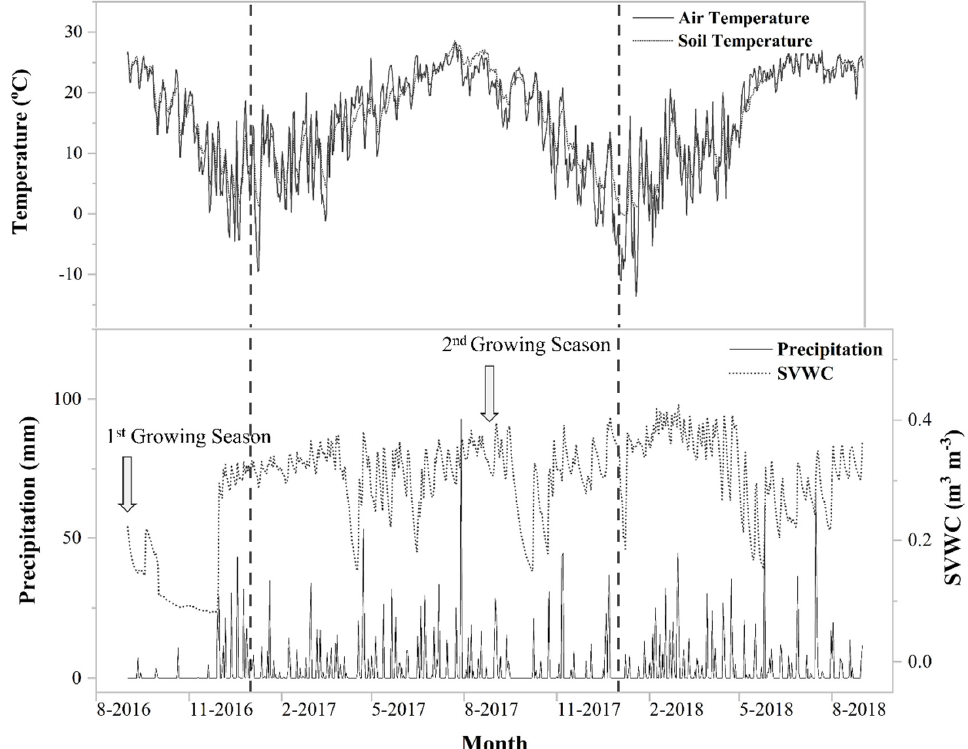
Figure 1. Daily ambient air and soil temperature (top), precipitation, and soil volumetric water content (SVWC, bottom) of a grass-dominated grassland ecosystem from the 2016–2017 and 2017–2018 growing seasons located in Middle Tennessee. Dashed lines separate years from each other.